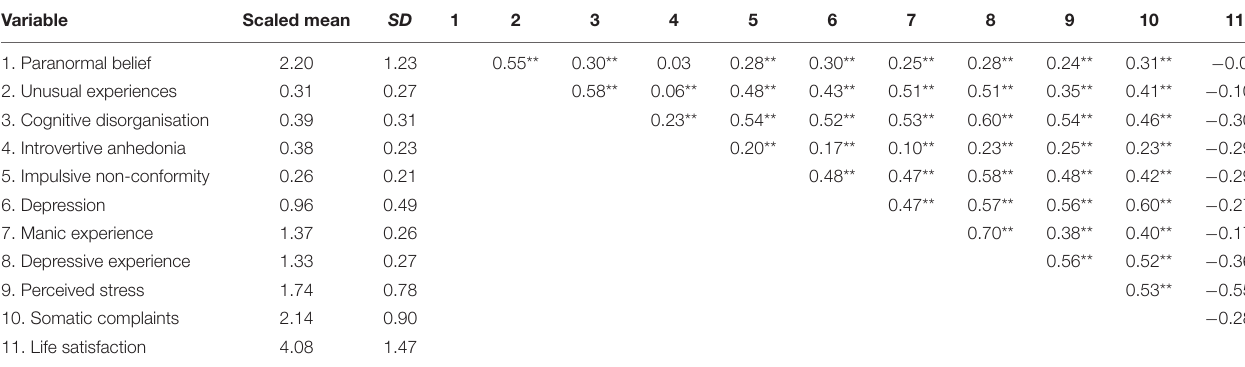
TABLE 1 | Descriptive statistics and intercorrelations among all study variables. Variable Scaled mean